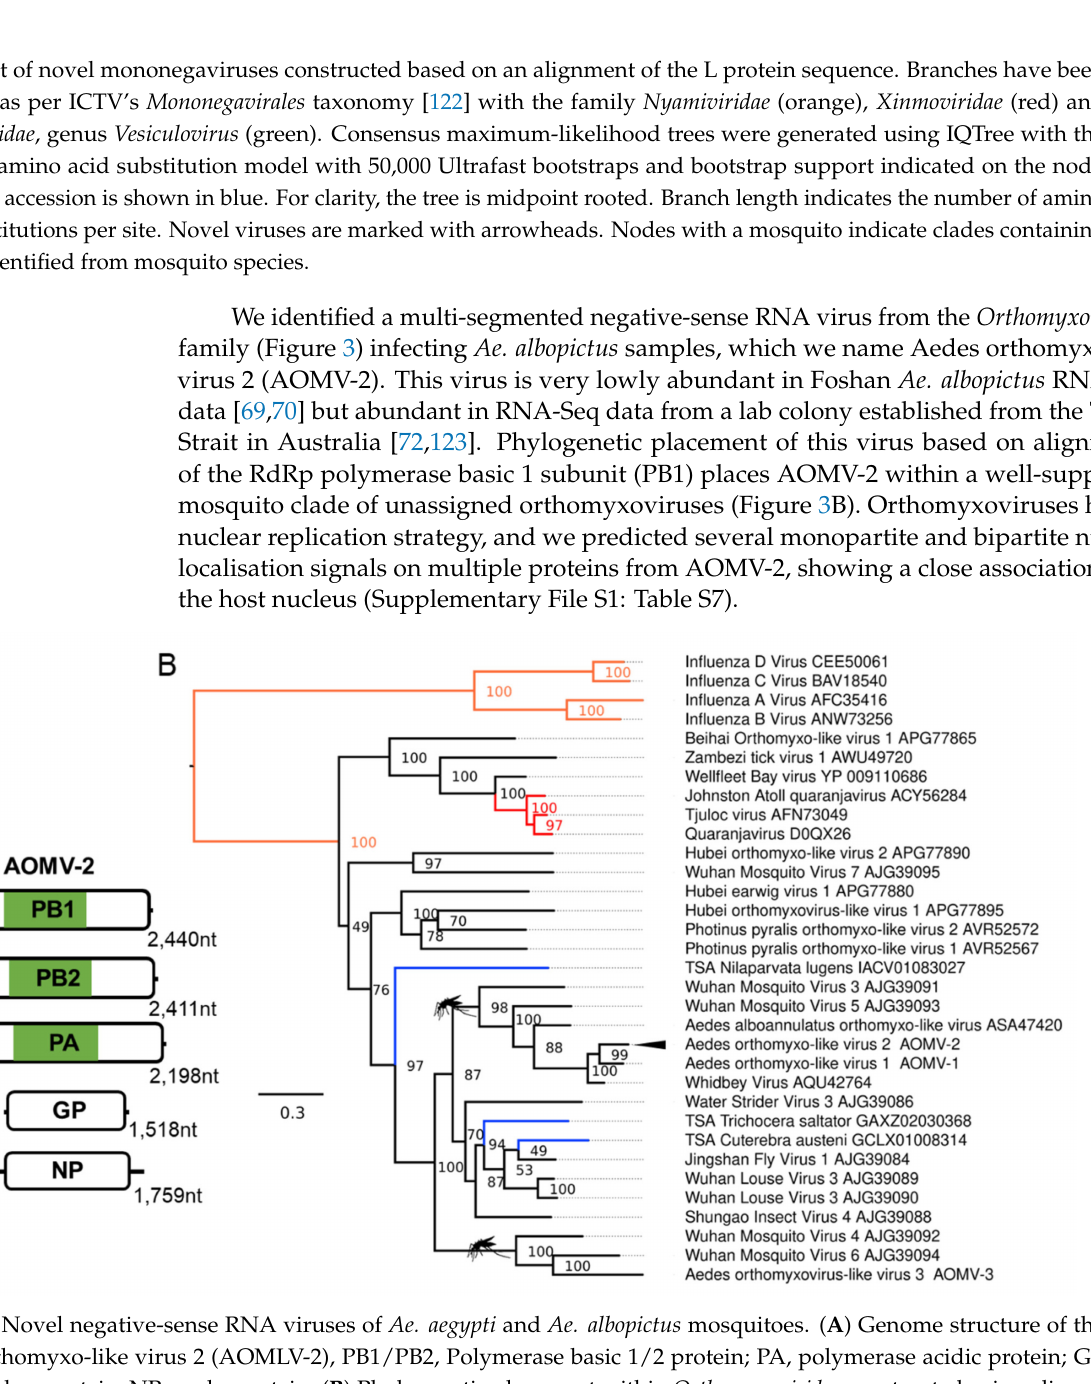
placement of novel mononegaviruses constructed based on an alignment of the L protein sequence. Branches have been coloured as per ICTV’s Mononegavirales taxonomy [122] with the family Nyamiviridae (orange), Xinmoviridae (red) and Rhabdoviridae , genus Vesiculovirus (green). Consensus maximum-likelihood trees were generated using IQTree with the LG + G4 amino acid substitution model with 50,000 Ultrafast bootstraps and bootstrap support indicated on the node. Each TSA accession is shown in blue. For clarity, the tree is midpoint rooted. Branch length indicates the number of amino acid substitutions per site. Novel viruses are marked with arrowheads. Nodes with a mosquito indicate clades containing viruses identified from mosquito species.